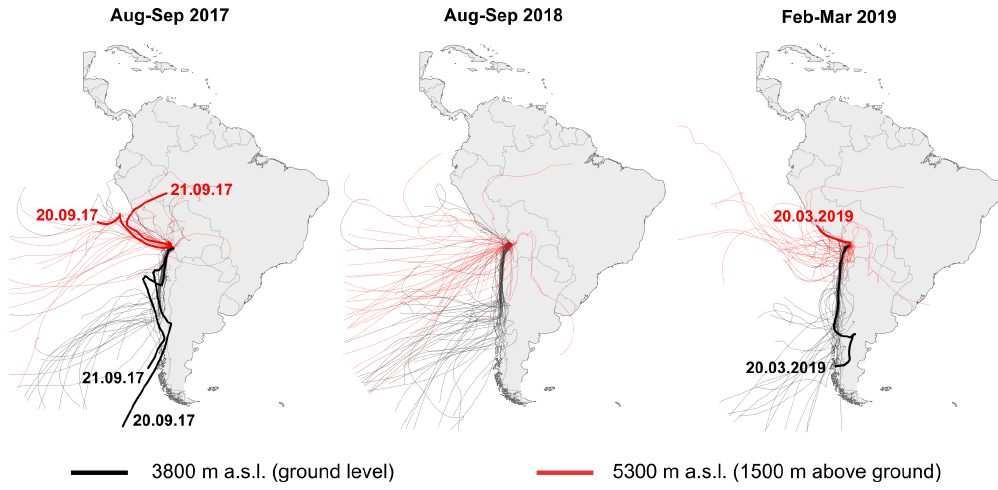
Figure 5. HYSPLIT 7d air mass back trajectories modelled for ground level at the Salar del Huasco ( ∼ 3800m above sea level, ma.s.l.) (black) and 1500m above ground level (5300ma.s.l.) (red) in daily resolution for the period from 23 August to 22 September 2017. The thick red and black trajectories represent modelled back trajectories for the time of vapour sampling on 20 September 2017, 21 September 2017, and on 20 March 2020.